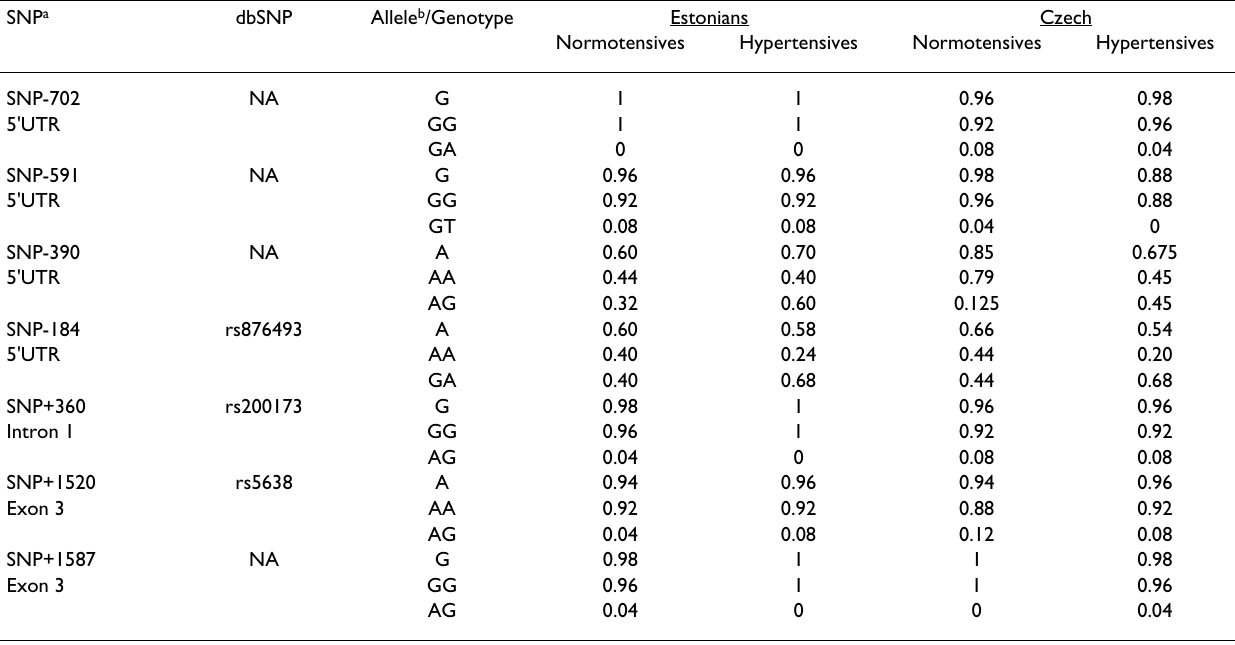
Table 2: Allele (major) and genotype (major homozygote, heterozygote) frequencies for identified SNPs by resequencing in Estonian and Czech normotensives and hypertensives SNP a dbSNP Allele b /Genotype Estonians Czech Normotensives